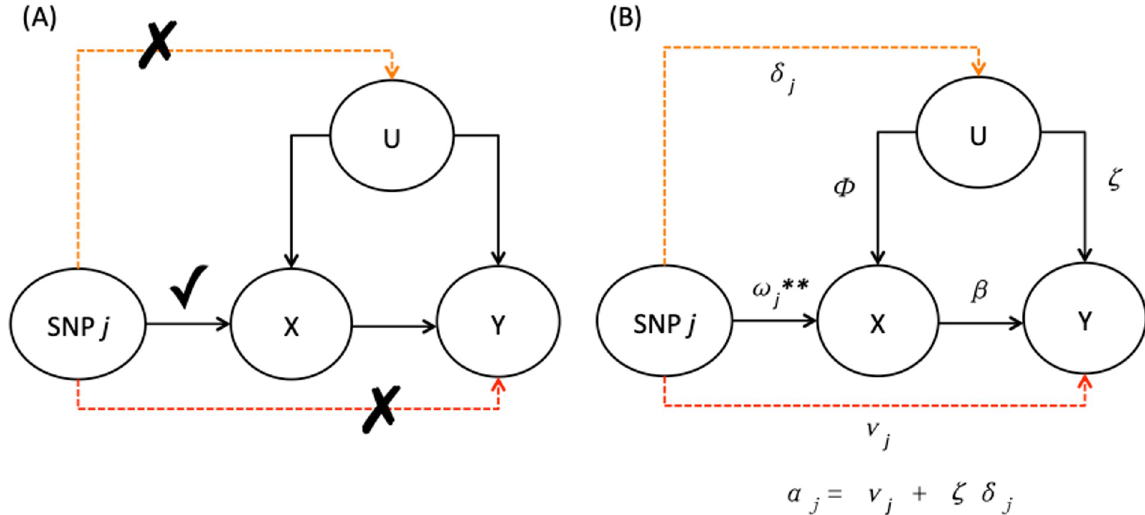
Fig 1. Illustrative diagrams for (A) valid IV assumptions and (B) horizontal pleiotropic effects violating two of the three IV assumptions.